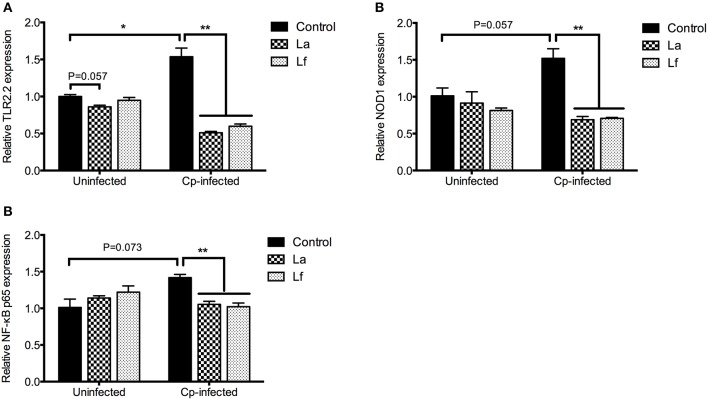
Quantification of TLR2.2, NOD1 and NF-κB p65 transcripts in the cells. Cells were pre-incubated with L. acidophilus or L. fermentum (MOI = 1) for 2 h and then stimulated with C. perfringens (MOI = 0.1) for 6 h. Following infection, the mRNA expression of TLR2.2 (A), NOD1 (B) and NF-κB p65 (C) were analyzed by qRT-PCR. Data are presented as mean ± standard error (n = 3). *P < 0.05, **P < 0.01. La, L. acidophilus; Lf, L. fermentum; Cp, C. perfringens; TLR, toll-like receptor; NOD, nucleotide-binding oligomerization domain; NF-κB, nuclear factor kappa B.